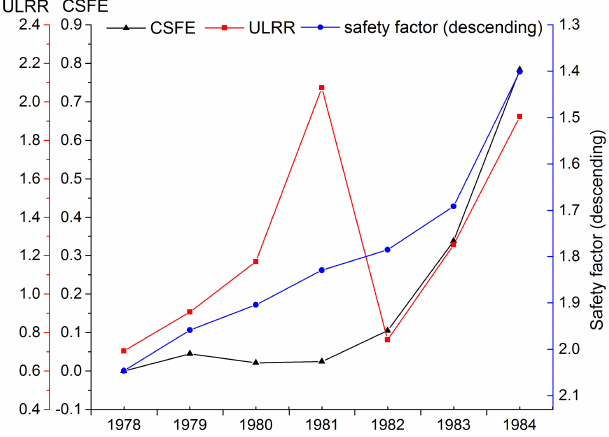
Figure 8. Comparison of CSFE with ULRR and safety factor of Xintan